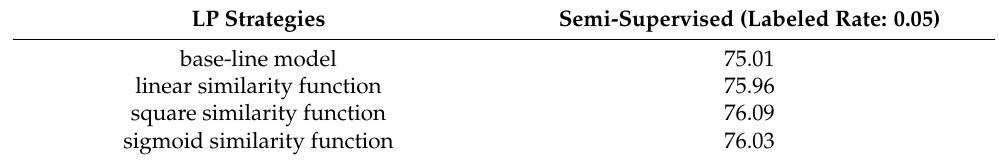
Table 2. Accuracy (%) of different similarity strategies in the cumulative confidence algorithm ( δ = 1).